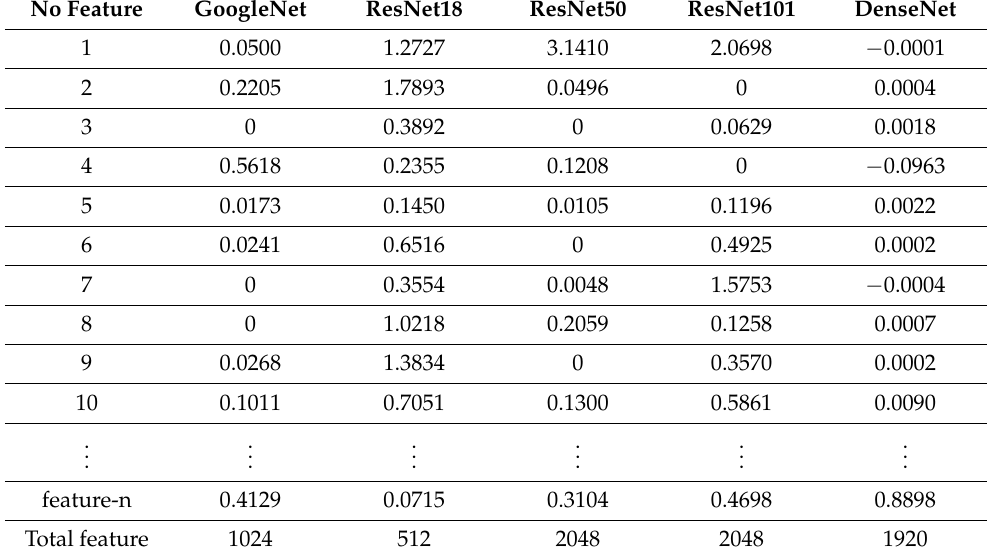
Table 1. Results on Feature Extraction CNN Architecture from A Fundus Image.